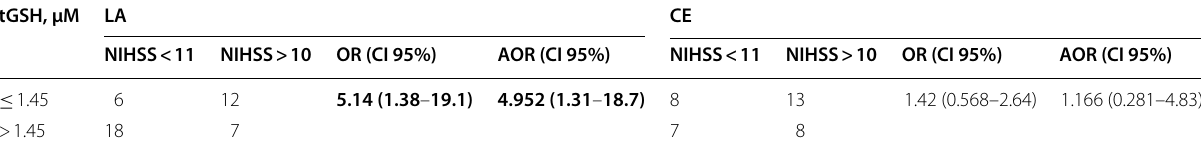
Table 2 Impact of tGSH on the risk of increased neurologic deficits (NIHSS) on admission in stroke patients